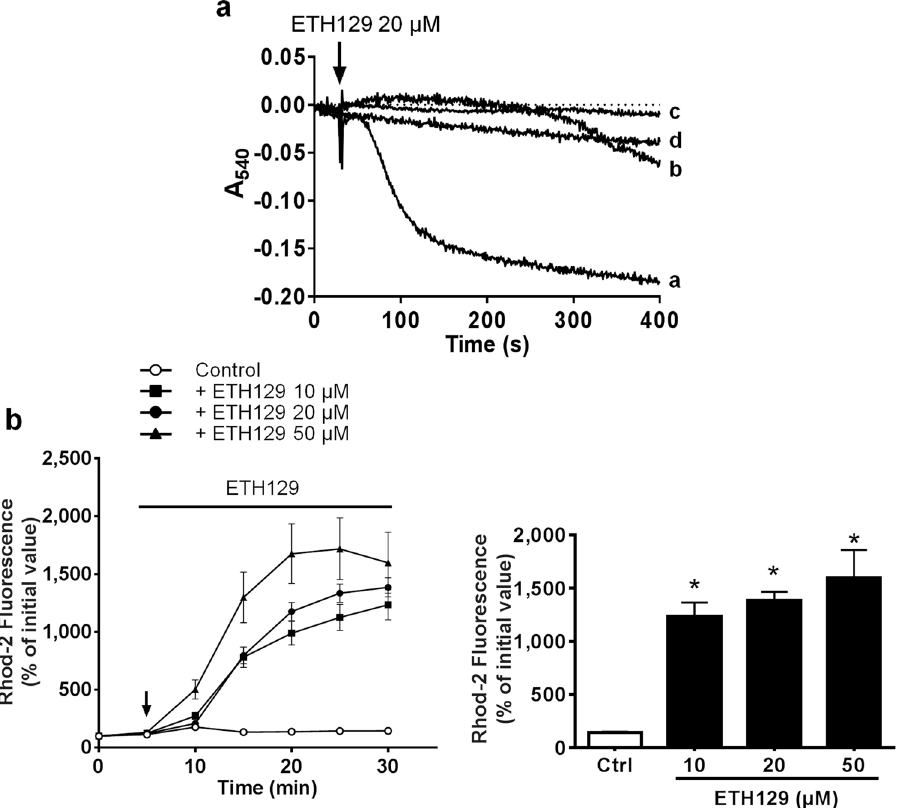
Figure 3. Effect of ETH129 on mitochondrial swelling and mitochondrial Ca 2 + in isolated cardiomyocytes. ( a ) Swelling was assessed in isolated rat cardiac mitochondria by measuring the change in absorbance of the mitochondrial suspension at 540 nm. Mitochondria were energised with pyruvate/malate (5/5 mM) in the presence of 10 µ M ruthenium red and 200 µ M Ca 2 + . Then 20 µ M ETH129 were added (arrow). Line a: Ca 2 + + ETH129; line b: Ca 2 + + ETH129 + CsA 2 µ M; line c: Ca 2 + alone; line d: ETH129 alone. ( b ) Isolated adult cardiomyocytes were loaded with 5 µ M rhod-2 for 40 min at 37 °C and then incubated in a Tyrode’s buffer. After 5 min incubation (arrow) ETH129 was added to the medium. Fluorescence values were obtained by averaging pixel intensities after background substraction and were normalised as a percentage of the initial value. Each trace represents the mean ± SEM of 3–5 experiments. * p < 0.05 versus control (Ctrl). The ordinates of the bar graphs are the values of rhod-2 fluorescence observed at 30